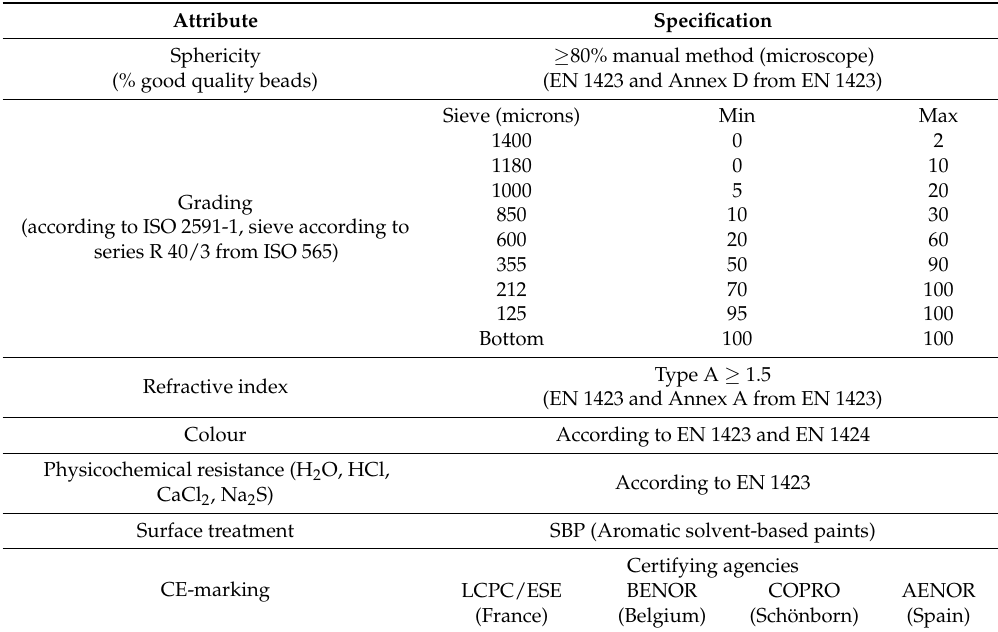
Table 5. Echostar 20 glass microbeads specifications.